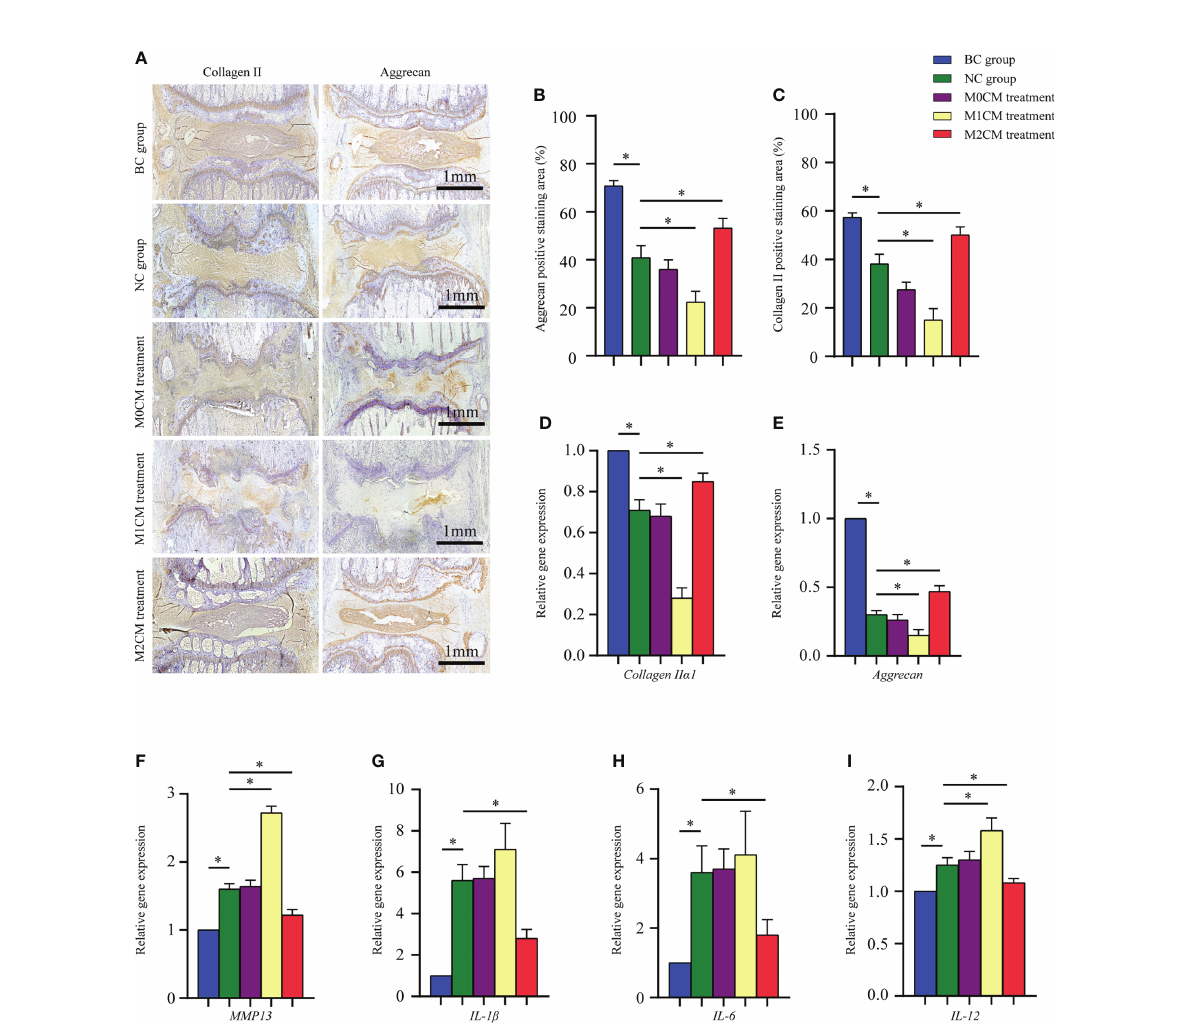
FIGURE 5 Effect of macrophage polarization on ECM metabolism and pro-in fl ammatory mediator secretion in rat coccygeal IVDs. (A) Representative immunohistochemical images showing rat coccygeal IVDs in different groups. (B, C) Semi-quanti fi cation analysis of collagen II and aggrecan staining in rat coccygeal IVDs 8 weeks after initial puncture and different treatments. (D – I) Effect of macrophage polarization on the gene expression of ECM components (aggrecan and collagen II a 1), ECM-modifying enzymes (MMP-13), and pro-in fl ammatory mediators (IL-1 and IL- 12) in rat coccygeal IVDs 8 weeks after puncture operation and different treatments. All data are expressed as the mean ± SD, n = 6, *P < 0.05, **P < 0.01. IVD, intervertebral disc; ECM, extracellular matrix; TNF- a , tumor necrosis factor- a ; CM, condition